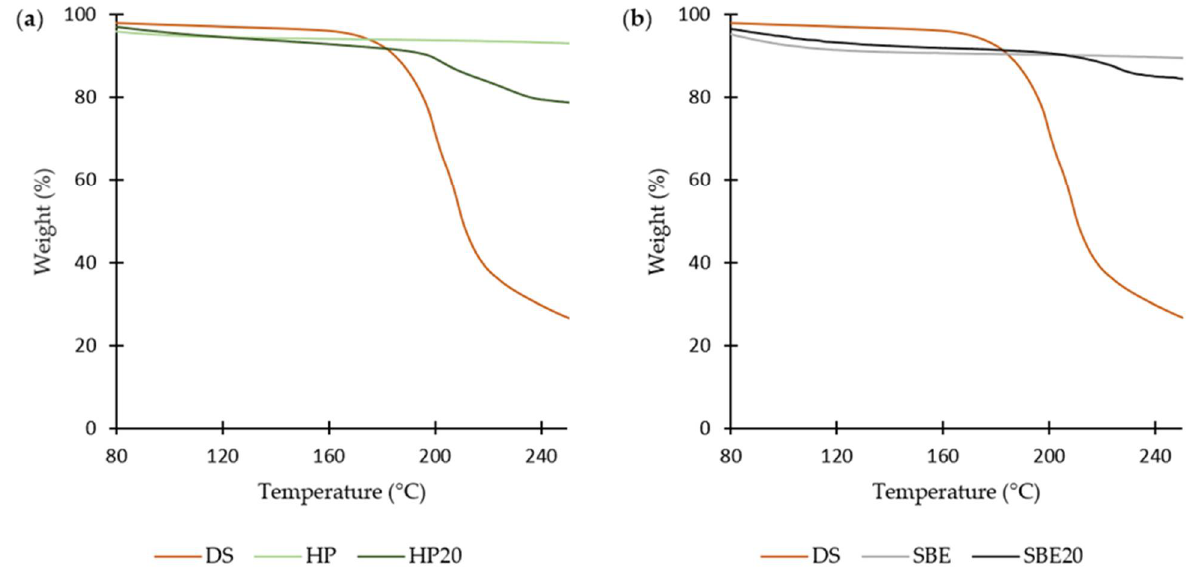
Figure 5. Thermogravimetric Analysis (TGA) thermographs of ( a ) DS, HP-CD, and HP-CD freeze- dried formulation; ( b ) DS, SBE-CD, and SBE-CD freeze-dried formulation.